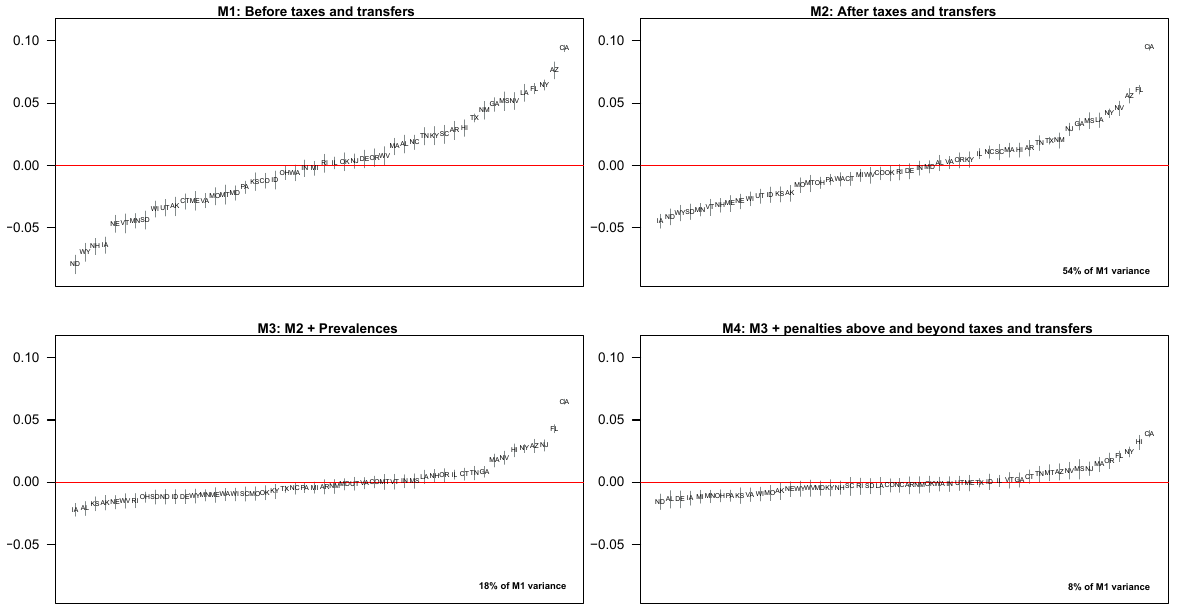
Figure 10. State random effects from hierarchical linear probability models predicting SPM poverty, 2012-2016 CPS.